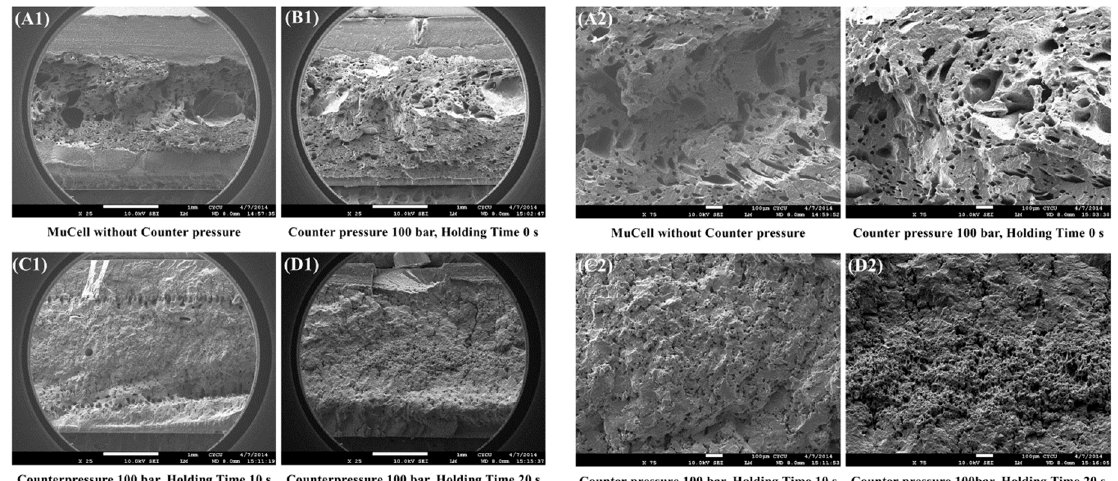
Figure 4. SEM pictures of fracture surface perpendicular to the flow direction with different holding times at GCP of 100 bar. Left (×25), right (×75).